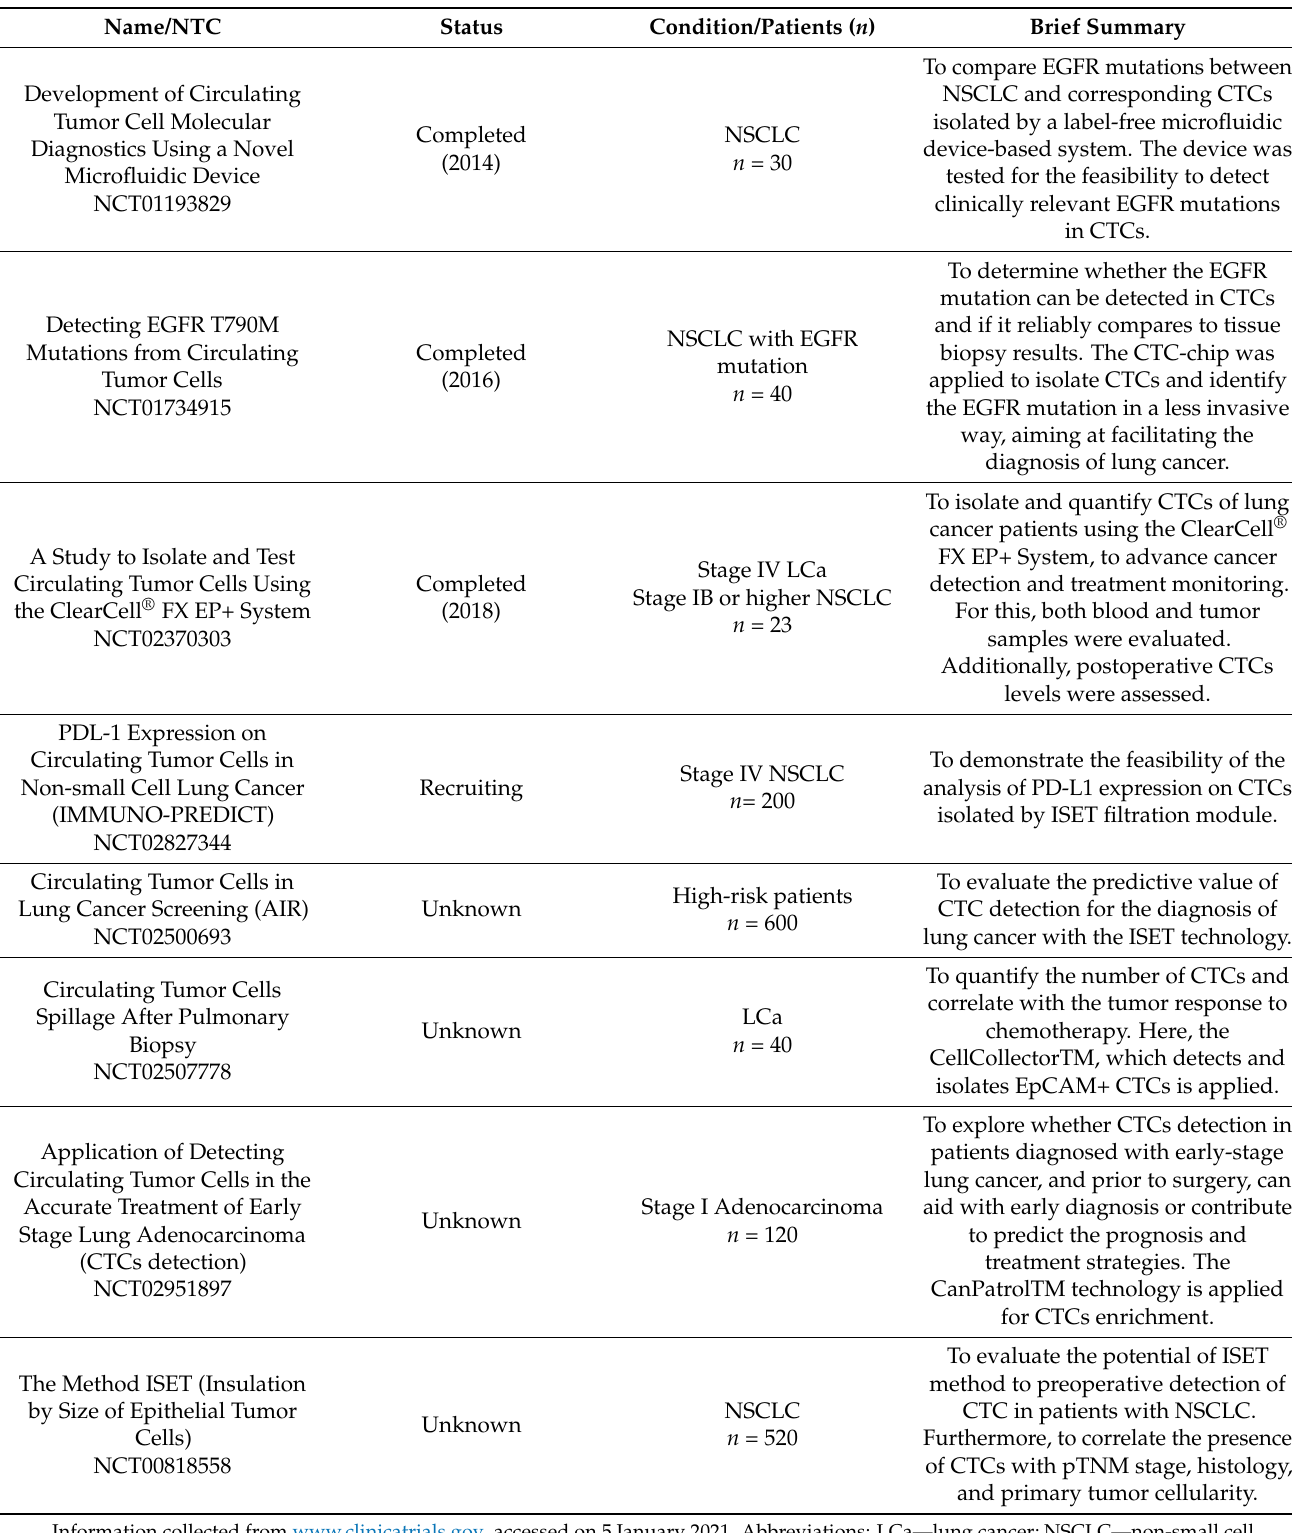
Table 1. Clinical trials regarding circulating tumor cells in lung